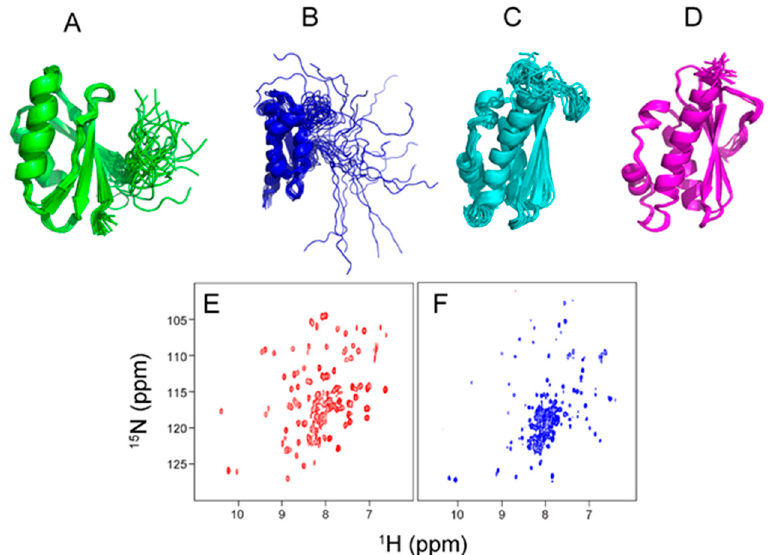
Figure 2. NMR studies of ISCU proteins. Solution NMR structures of: ( A ) E. coli apo-IscU(D39A), a variant that is fully in the structured state (PDB: 2KQK); ( B ) the structured-form of wild-type E. coli apo-IscU (PDB: 2L4X); ( C ) zinc-bound Haemophilus Influenzae IscU (PDB: 1R9P); and ( D ) zinc-bound Mus musculus ISCU (PDB: 1WFZ) [87,88]. Zinc-binding stabilizes the structured state. 1 H- 15 N HSQC spectra of: ( E ) E. coli apo-IscU; and ( F ) human apo-ISCU at pH 7.5 and 25 ◦ C. These spectra contain signals from both the structured and disordered states of the protein and show that human ISCU is more disordered than E. coli IscU. See Refs. [84,85] for